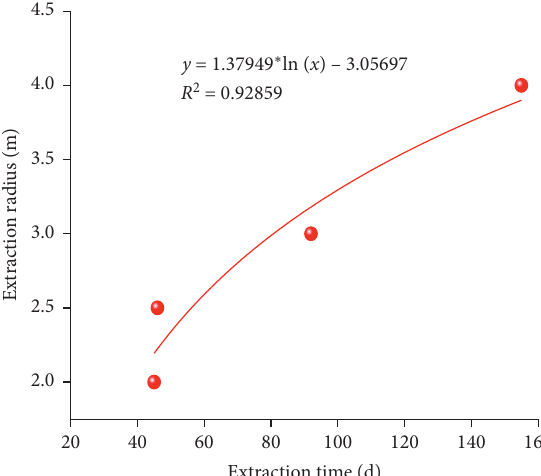
Figure 12: Fitting curve of the extraction radius with extraction time in the No. 25 drilling